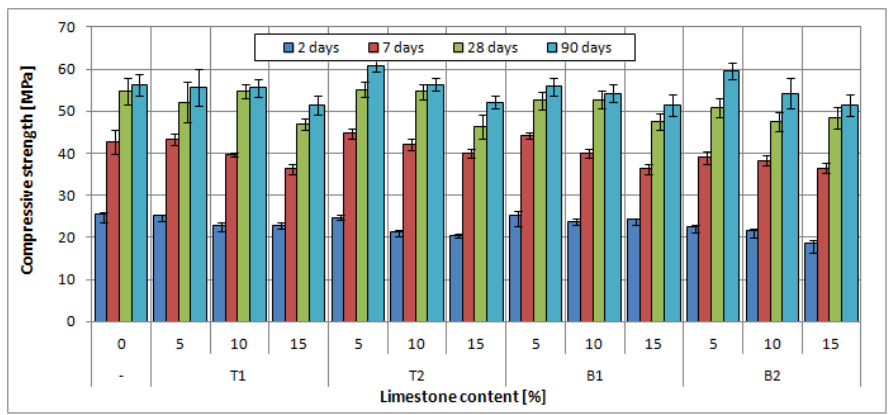
Figure 10. Compressive strength of blended slag-limestone cements made of CEM II/B-S 42.5N.